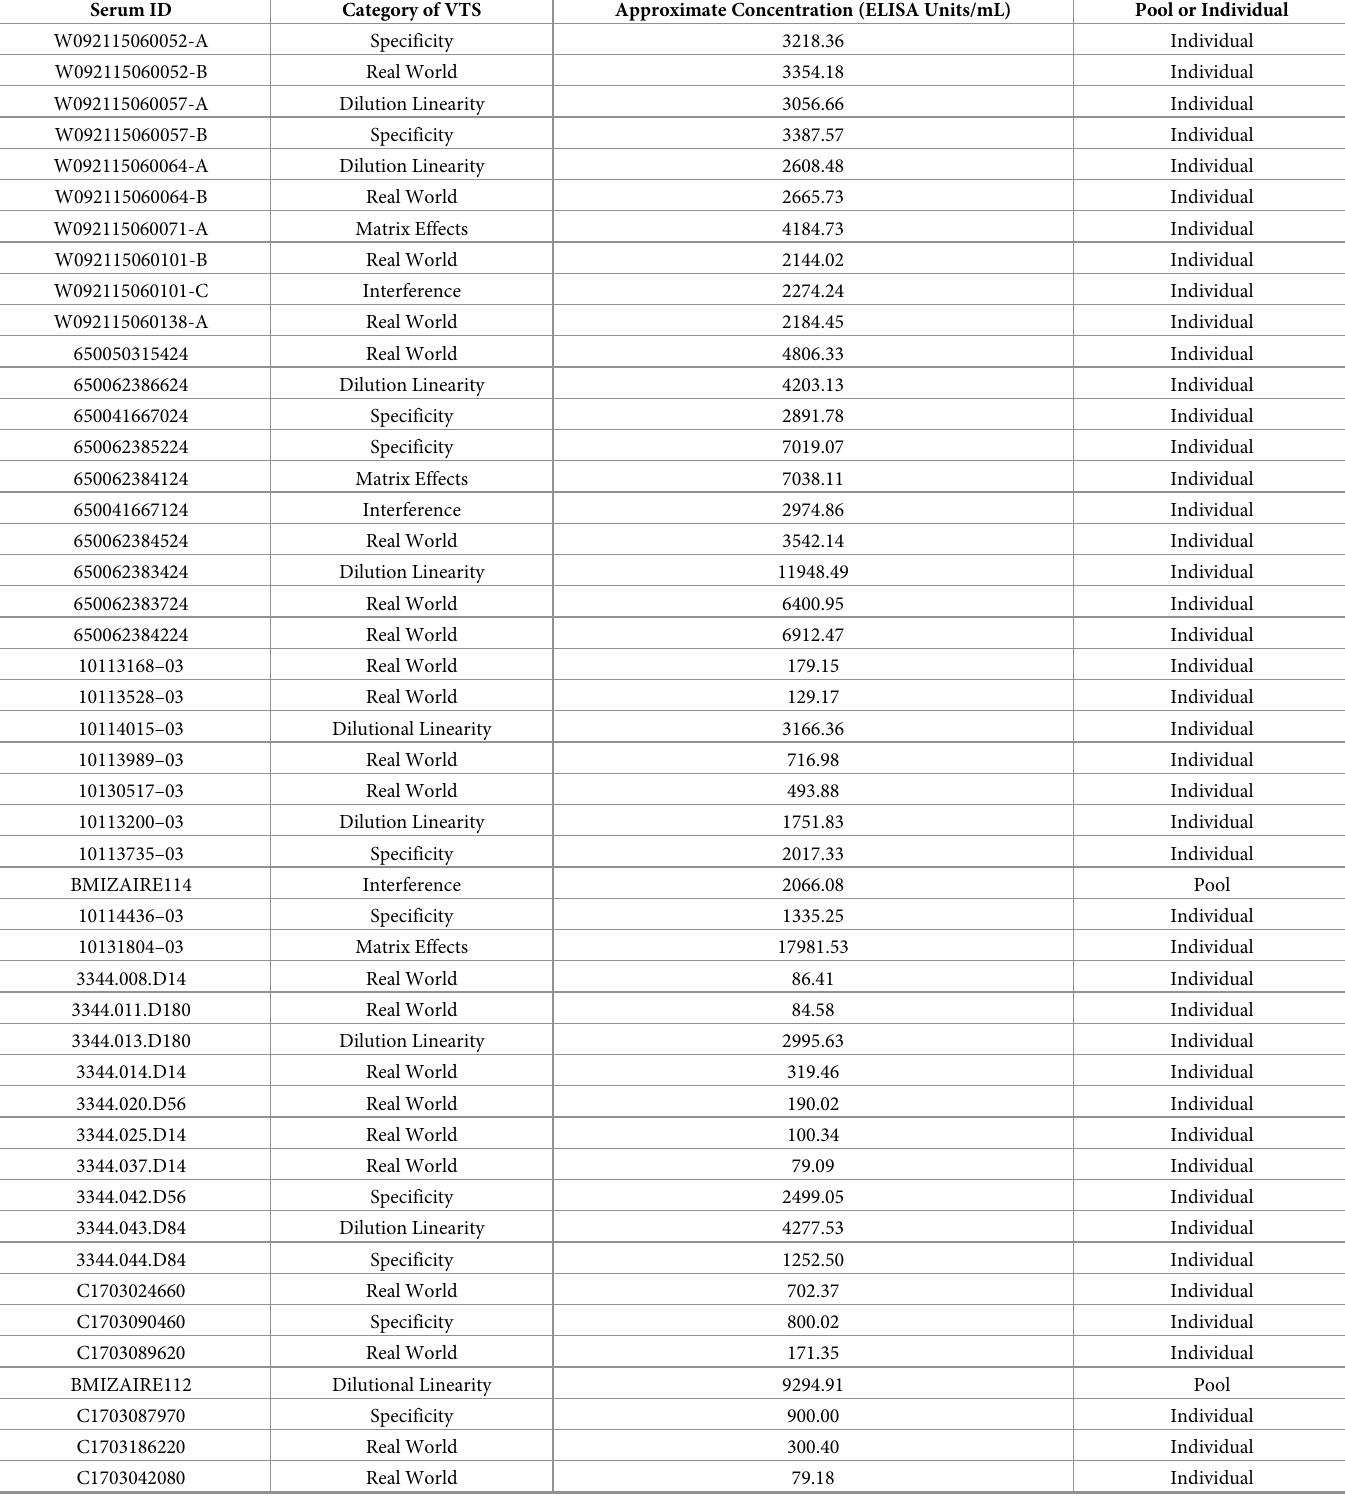
Table 7. Immune human serum samples used to generate